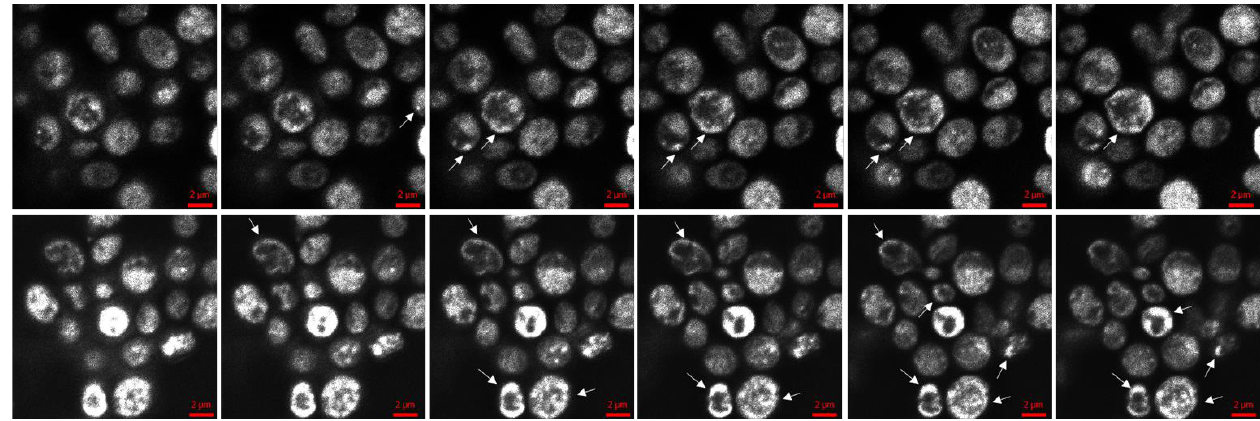
Figure 4. Afr3 Localizes in the Plasma Membrane. S. cerevisiae ADΔ cells expressing AFR3 -GFP show fluorescence on the cell surface, suggesting localization at the level of the plasma membrane. White arrows point to localization within fungal cells. Images were obtained through the generation of ten Z stacks, six of which are represented in this image.